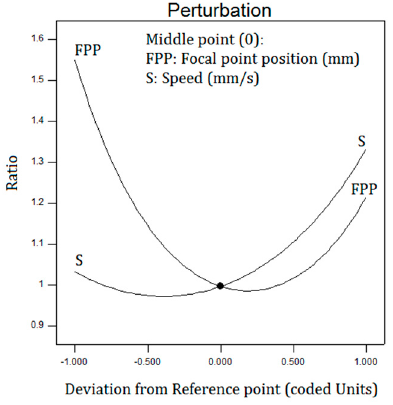
Figure 12. Perturbation plot of the ratio of top kerf to bottom kerf.